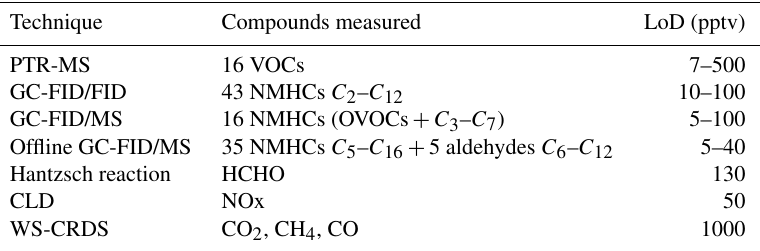
Table 2. Summary of the experimental methods deployed during the field campaign and needed for calculating the OH reactivity. The number of measured compounds includes the compounds below the instrumental detection limit